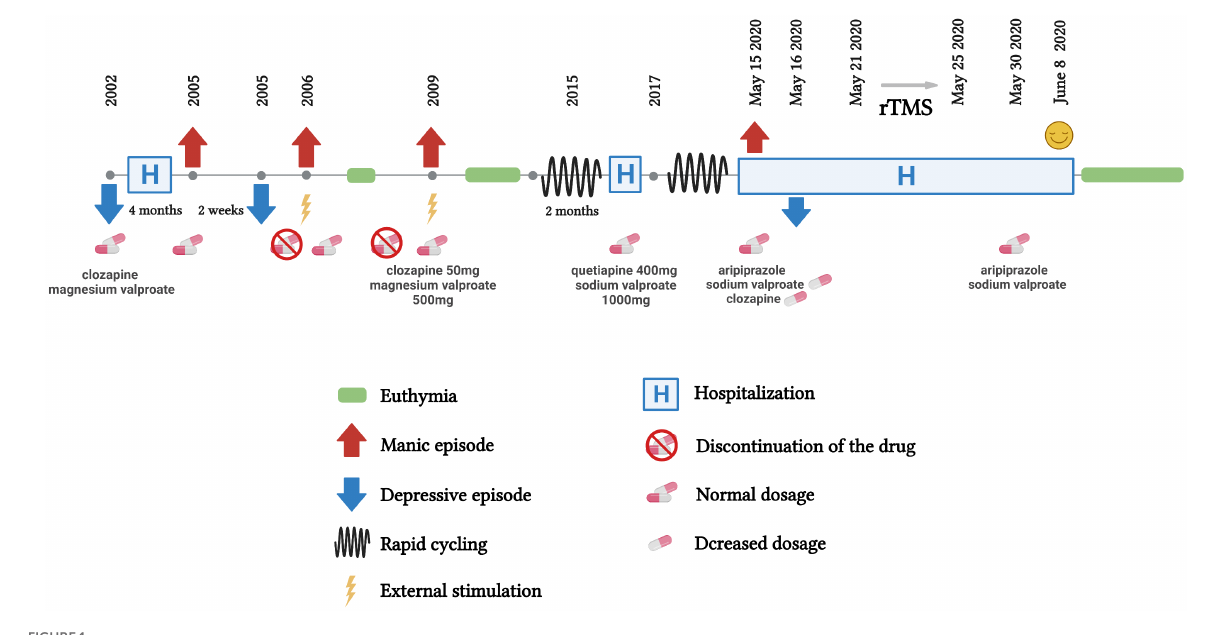
FIGURE 1 Symptoms and treatment course of the